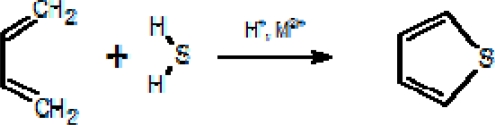
Synthesis of C4H4S from butadiene.